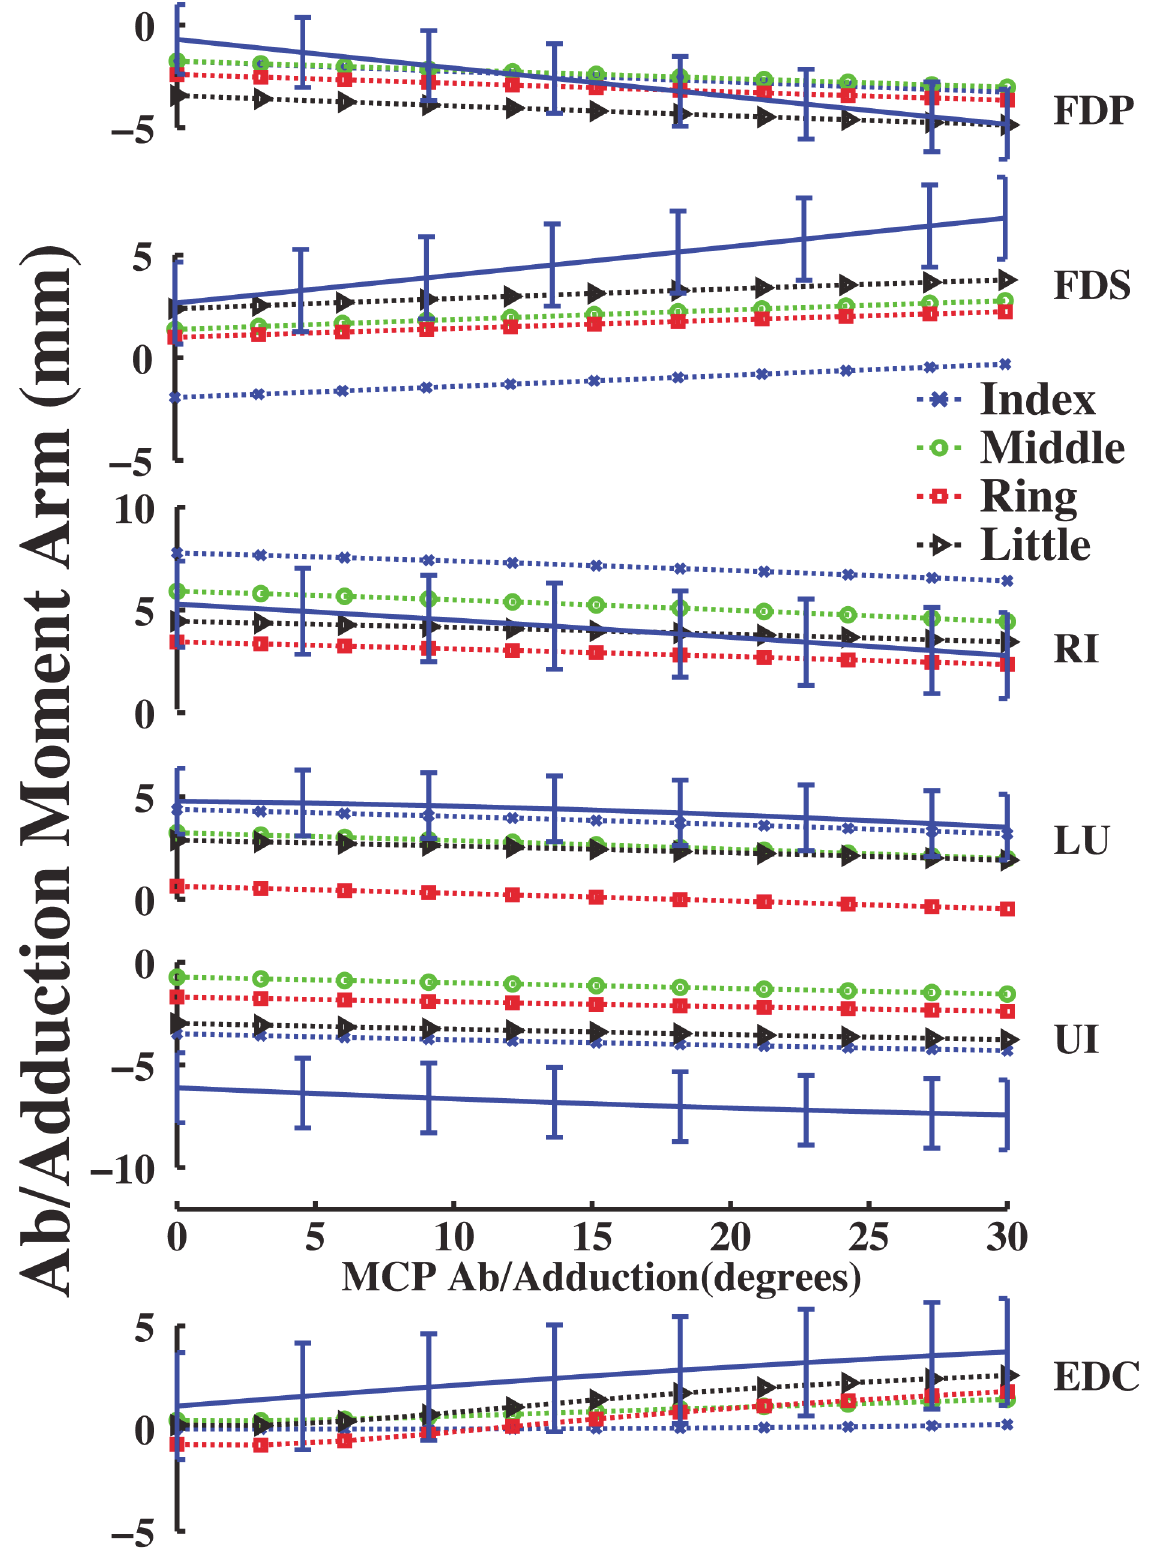
Fig 3. Ab/adduction moment arms (mm) as a function of abduction (+)/ adduction (-) at the MCP joint of the all fingers. Symbols are the same as in Fig 2. doi:10.1371/journal.pone.0121712.g003 PLOS ONE | DOI:10.1371/journal.pone.0121712 April 8,